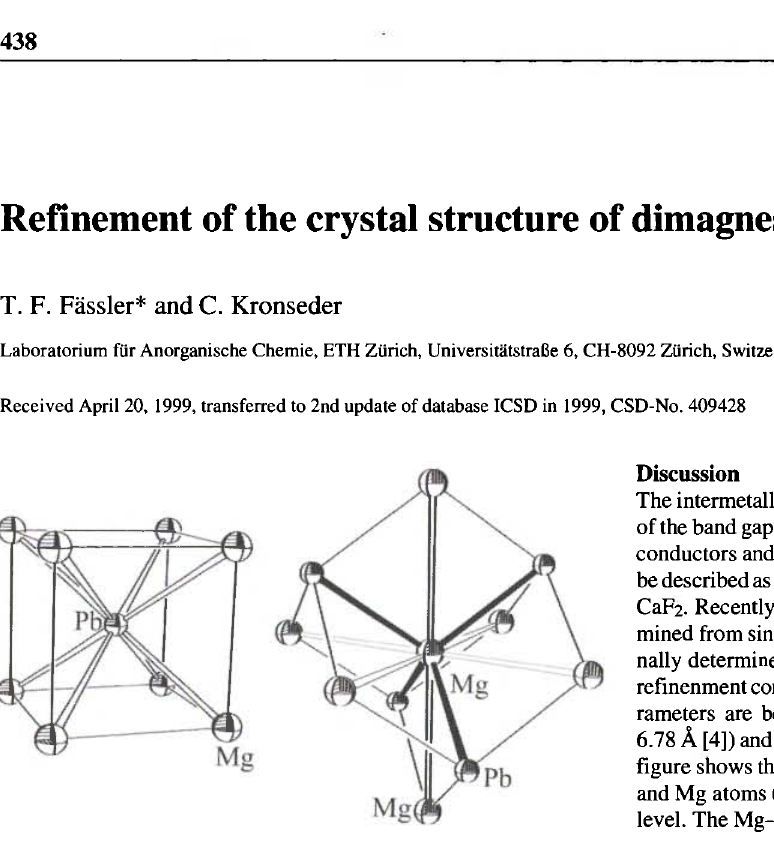
Table 1. Data collection and handling.